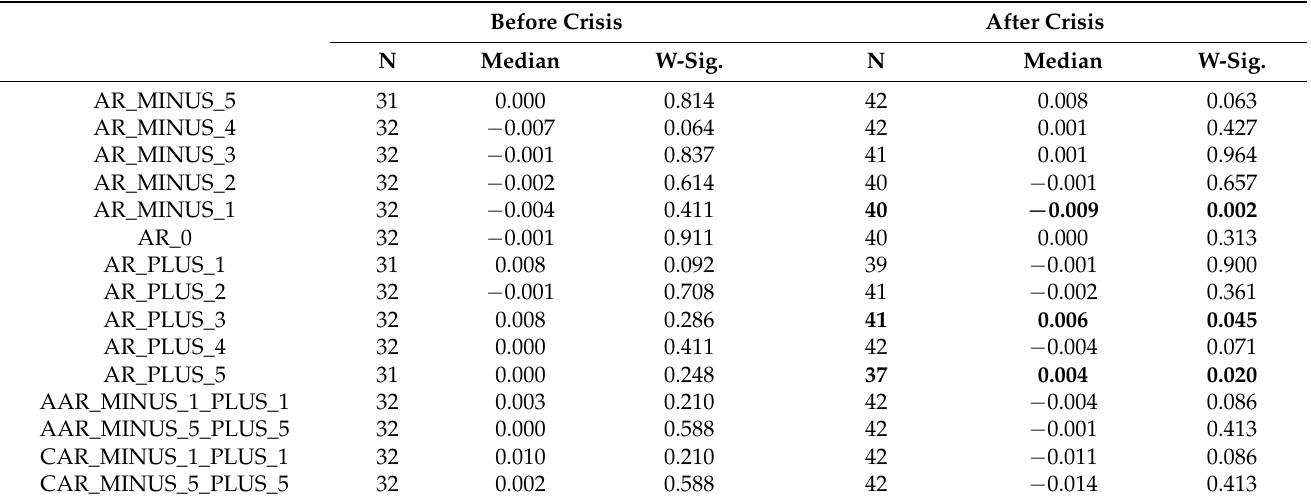
Table 10. Non-parametric